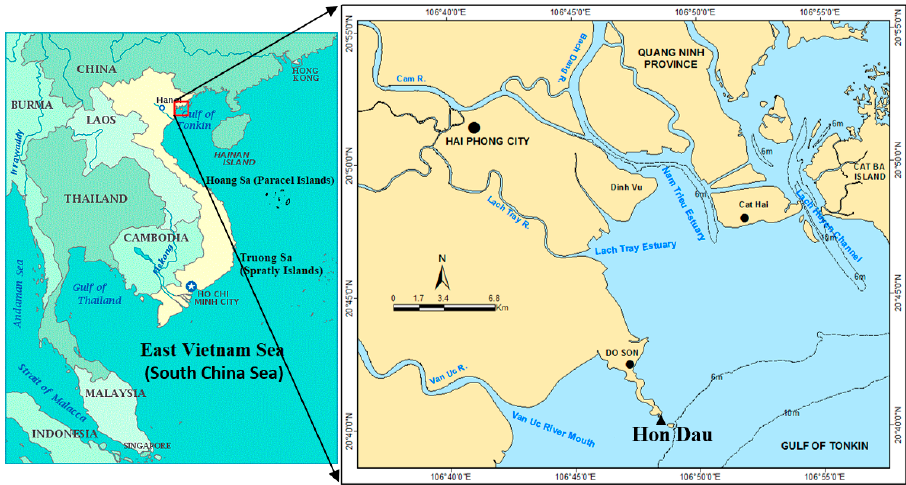
Figure 1. The Hai Phong coastal area and the Hon Dau station.